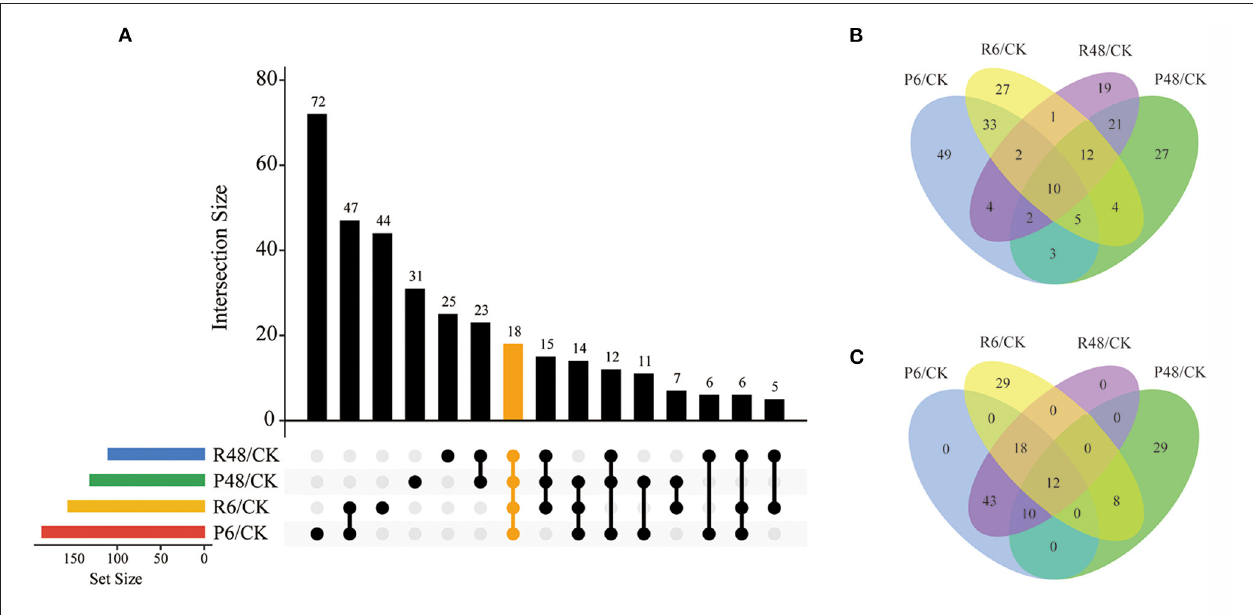
FIGURE 5 | Venn diagram analysis of DPPs under different treatments. (A) All DPPs for the four treatments. The bar charts indicate the number of DPPs under Pi starvation for 6h (P6/CK) and 48h (P48/CK), and Pi resupply 6h (R6/CK) and 48h (R48/CK); (B) Upregulated DPPs identified in P6/CK, P48/CK, R6/CK, and R48/CK; (C) downregulated DPPs identified in P6/CK, P48/CK, R6/CK, and R48/CK. DPPs, differentially phosphorylated proteins.